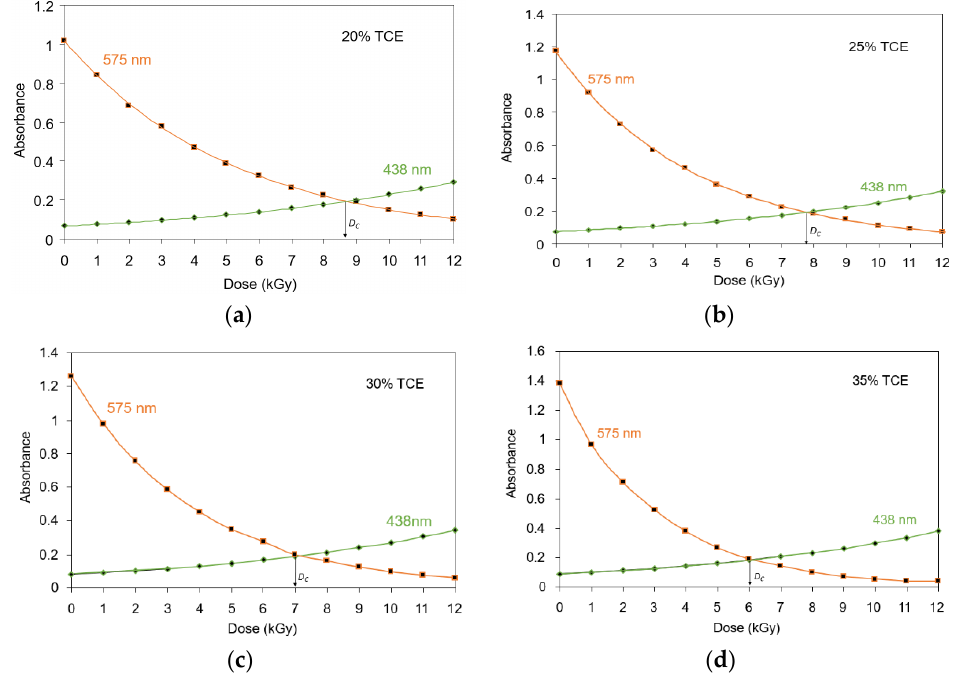
Figure 4. Critical doses determined as the intersection of absorbance at 575 nm and 438 nm bands for PVA-TCE-CR polymer film containing ( a ) 20%, ( b ) 25%, ( c ) 30%, and ( d ) 35% TCE.